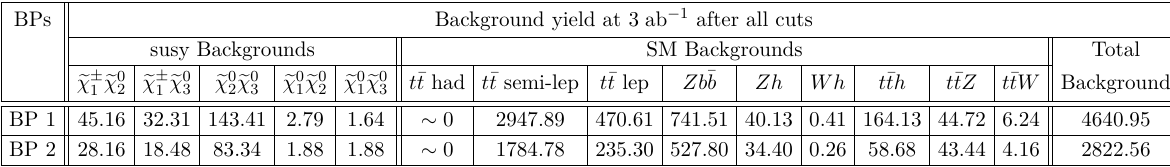
Table 17. The background yield at 14 TeV with 3 ab − 1 of integrated luminosity after the cut-based analysis for the two benchmark points in the b-tag